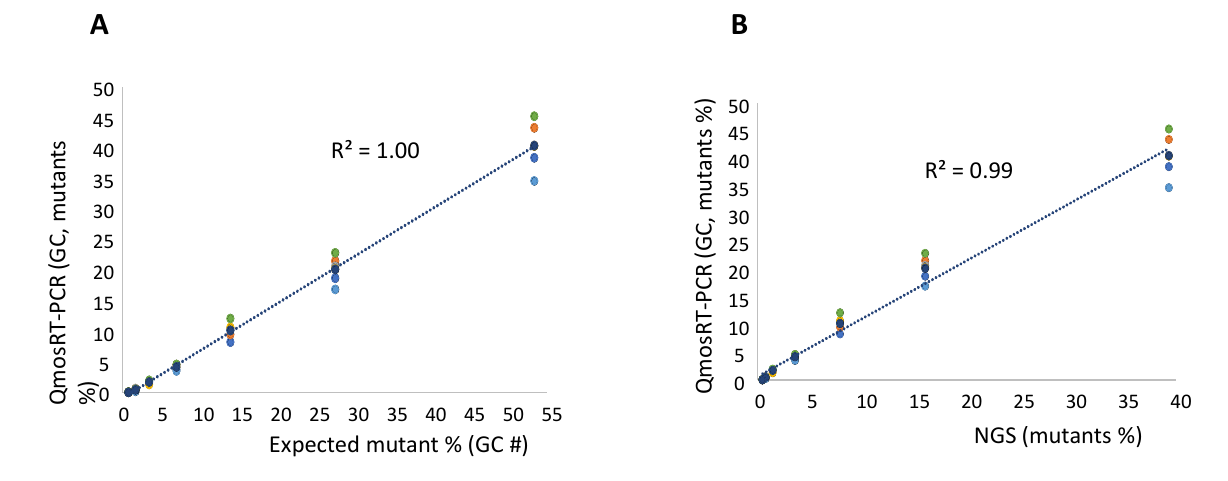
Figure 4. Results of qmosRT-PCR assay using plasmid refence standards for quantification of nOPV2-c1_295 mutants, generated from the virus-spiked samples: ( A ) the mutant percentages generated by qmosRT-PCR are plotted against the expected percentages of mutants and ( B ) the mutant percentages generated by qmosRT-PCR are plotted against the results of Illumina sequencing (NGS). The correlation line is drawn for the averages of the qmosRT-PCR results. The results of different qmosRT-PCR runs (Table 4) are presented with different colors.